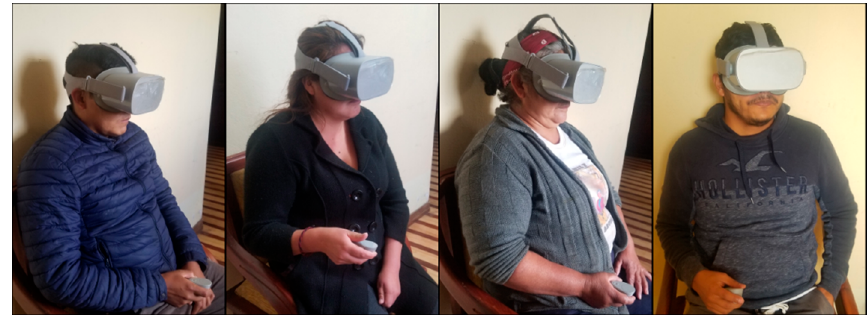
Figure 10. Participants using the immersive virtual reality application.